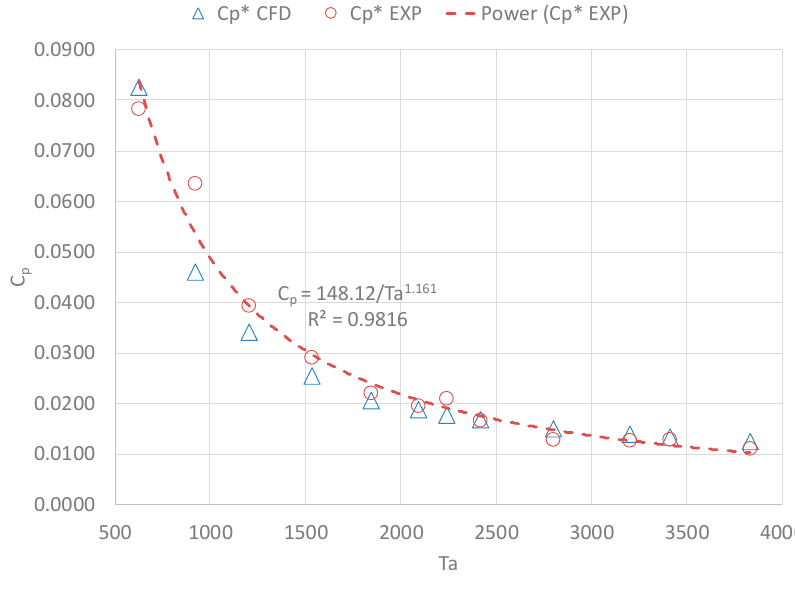
Figure 18. Experiment and numerical windage results in terms of power coefficient.